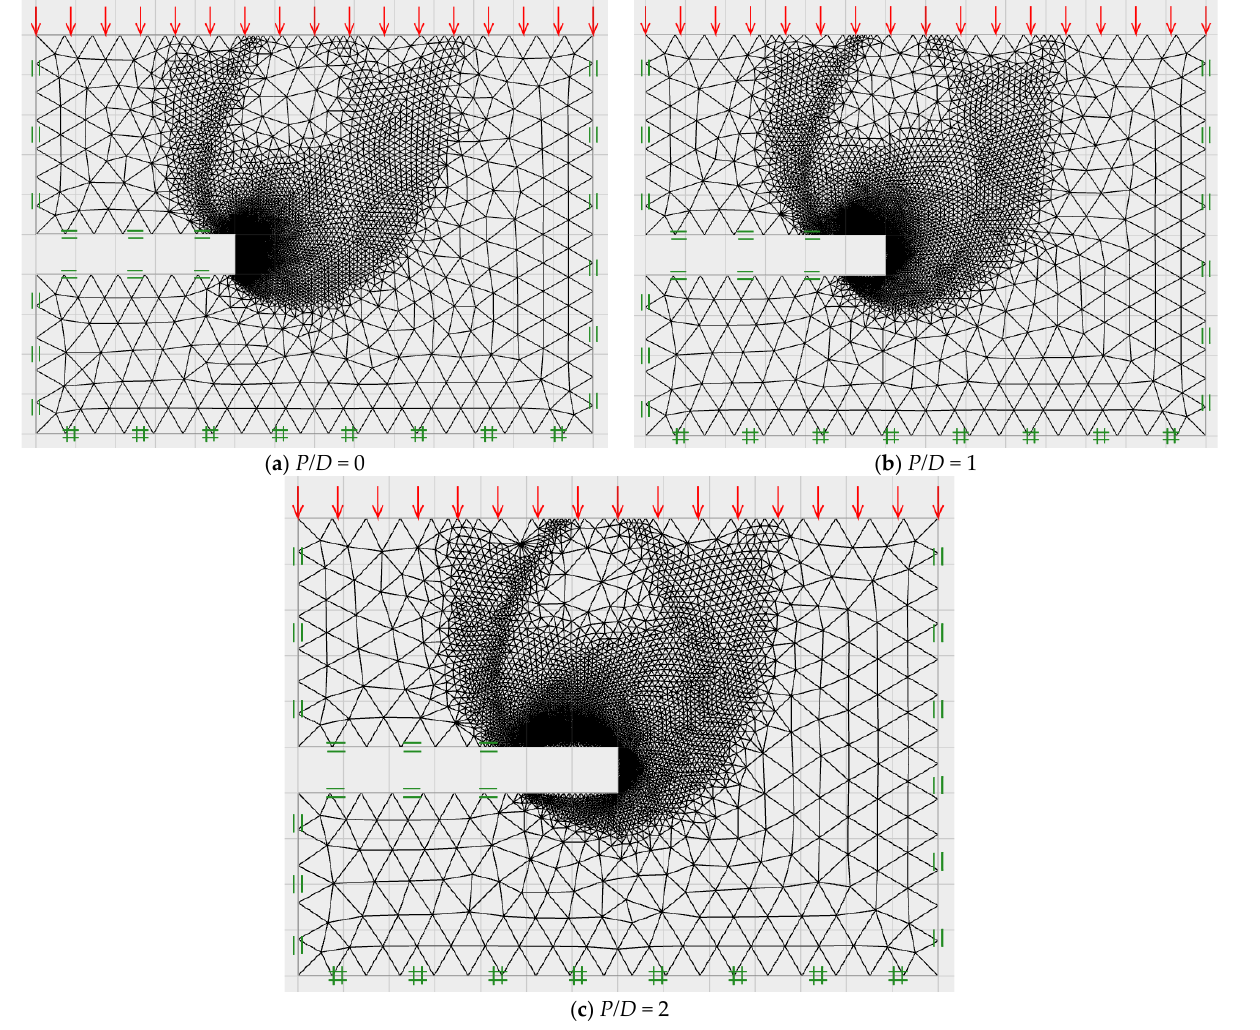
Figure 3. Typical adaptive meshes of tunnel headings in rock masses ( C/D = 5, γ D/ σ ci = 0.01, GSI = 40, and m i = 30).